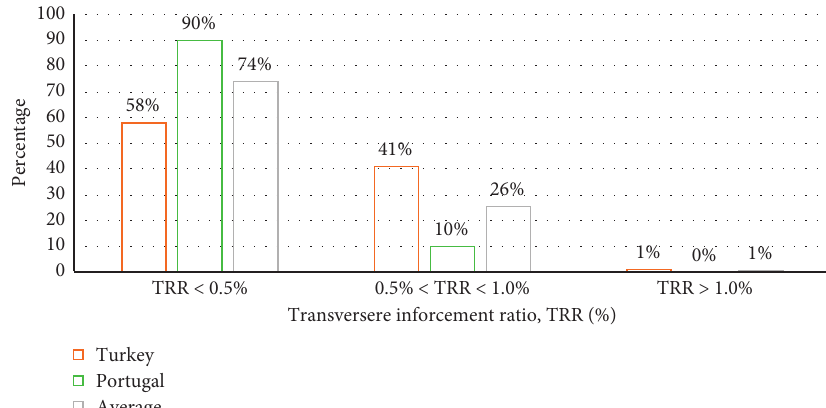
Figure 33: Comparison of transverse reinforcement ratio of precast RC buildings in Portugal and